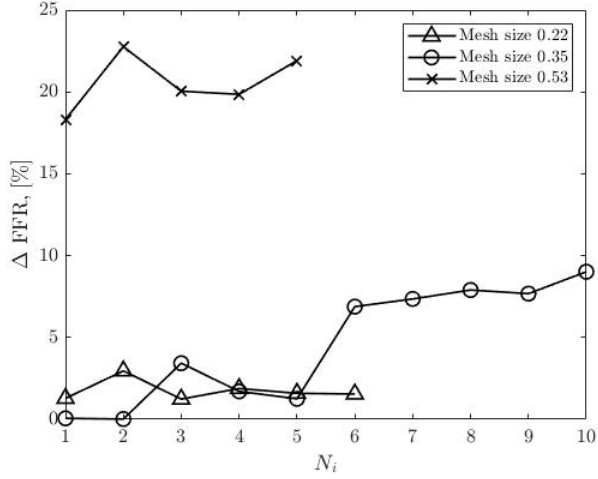
Figure 14. Relative differences between calculated and experimental FFR in each round of iteration for CHN13 [19].